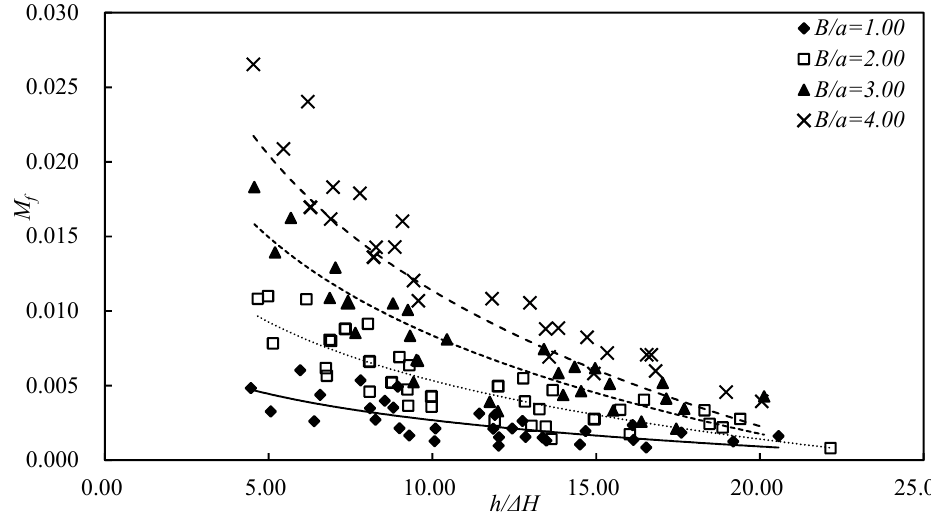
Figure 6. Relationship between M f and the draft depth.